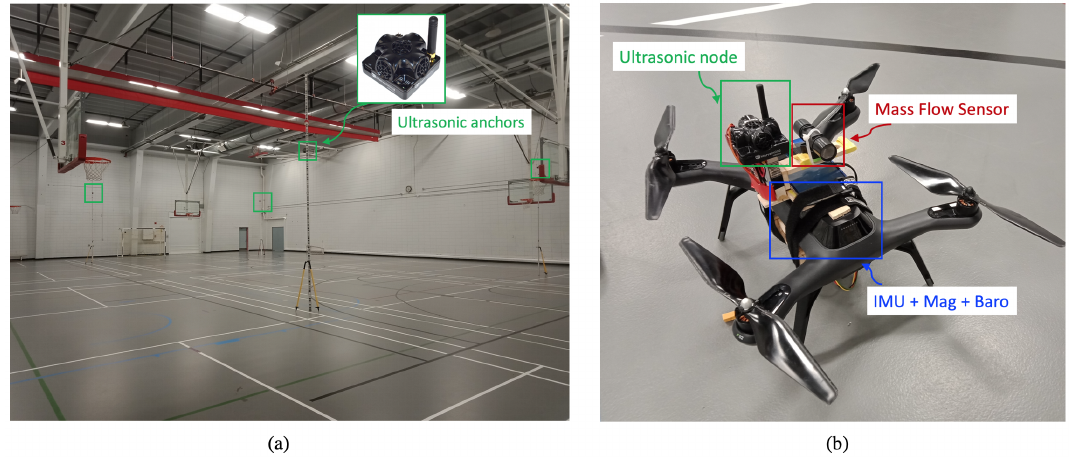
Figure 2. ( a ) Test environment and ( b )